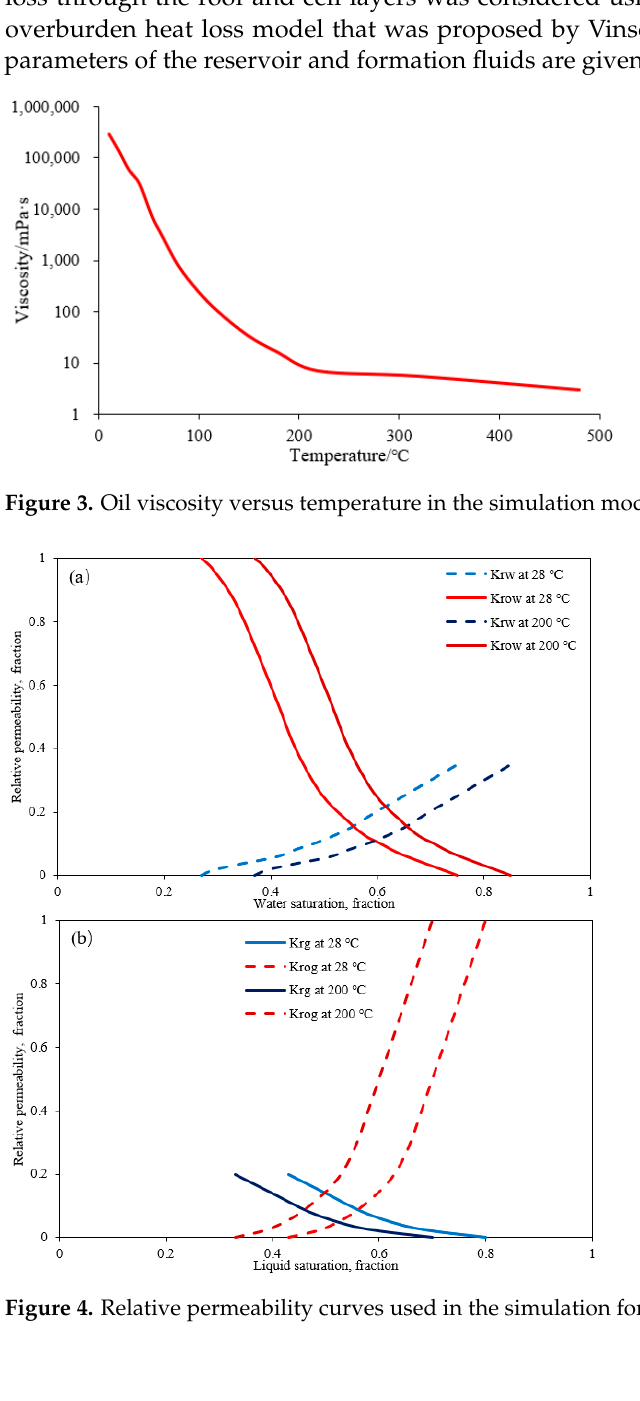
Table 2. The key thermal reservoir parameters.